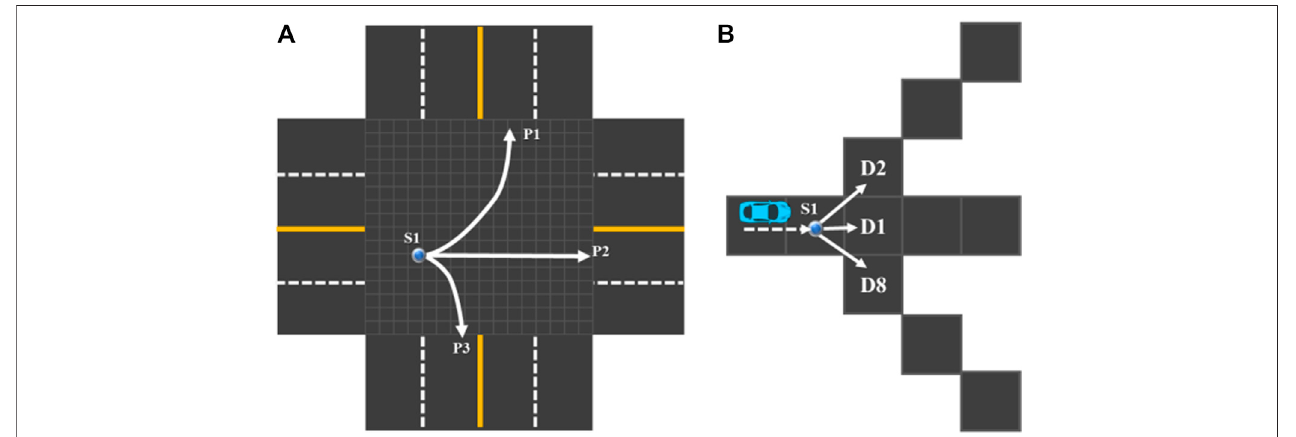
FIGURE 11 | The vehicle has multiple expected driving directions. (A) Vehicle with multiple expected driving paths. (B) Vehicle with multiple expected driving directions.